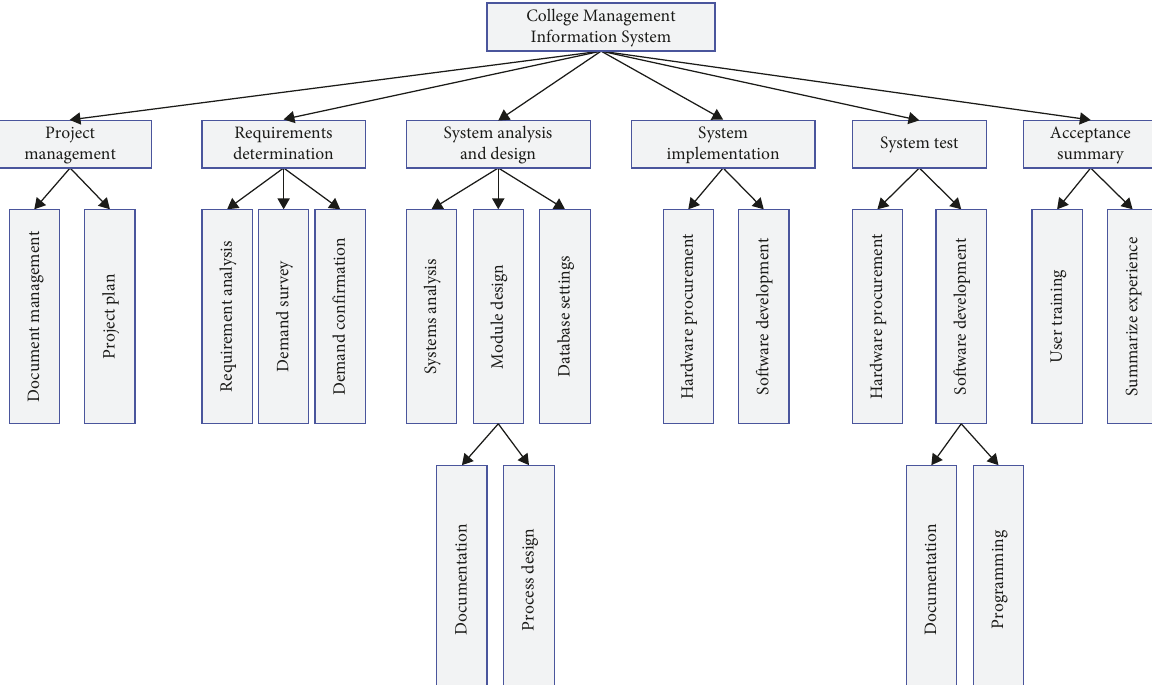
Figure 3: Structure decomposition of teaching management information